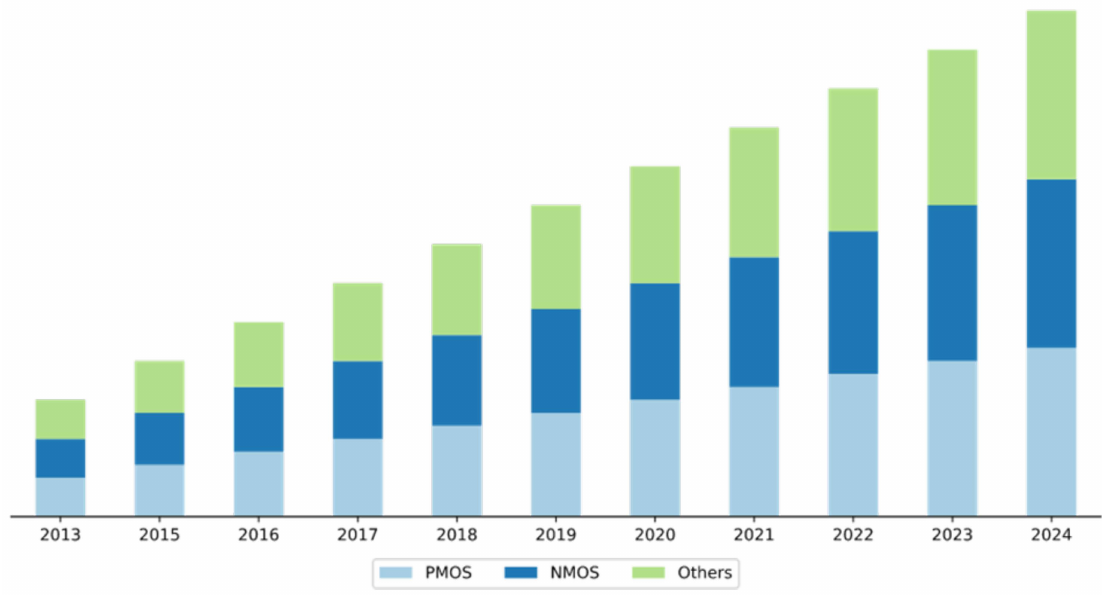
Figure 7. LDO market share